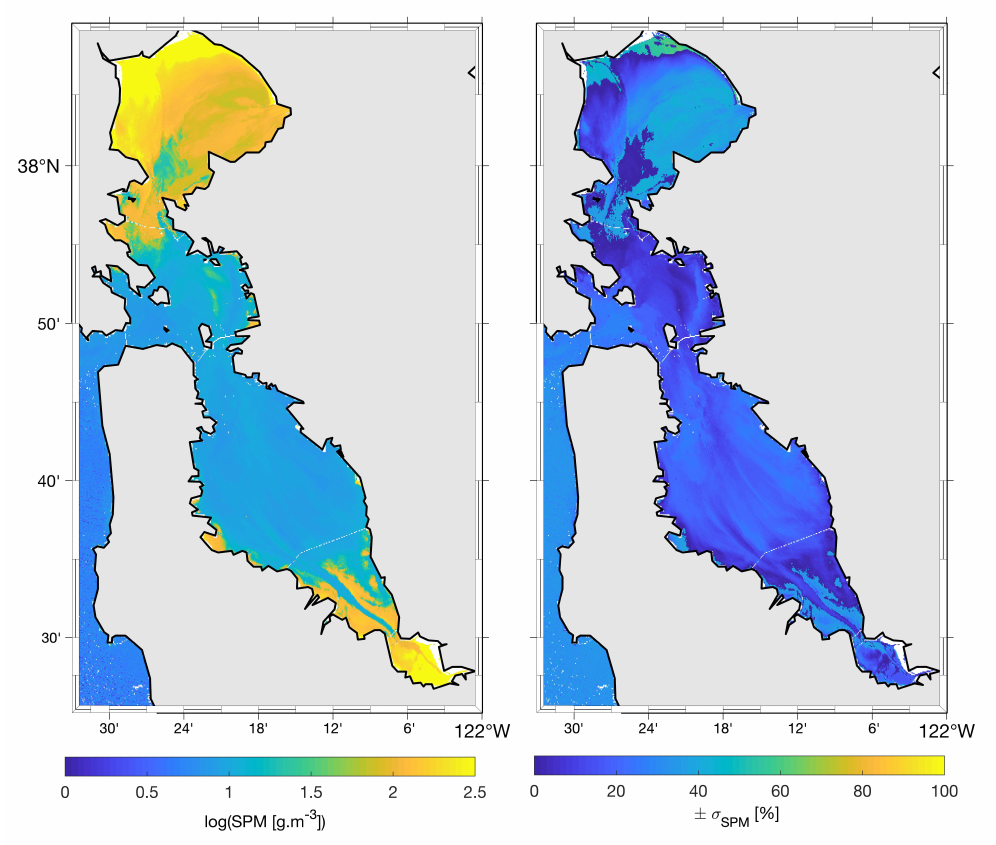
Figure 7. SPM retrieval and uncertainties of the method for San Francisco Bay, California-USA. Using red, near-infra-red (NIR), short-wave-infra-red (SWIR) bands (655, 865, and 1609 nm,